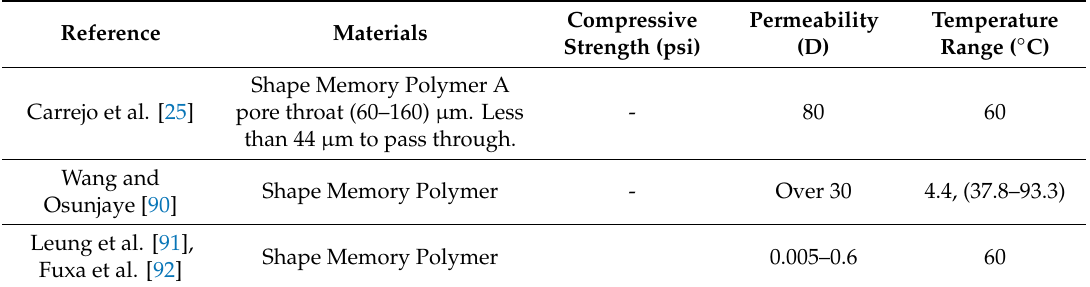
Table 13. Shape memory polymers methods to consolidate sand formation.